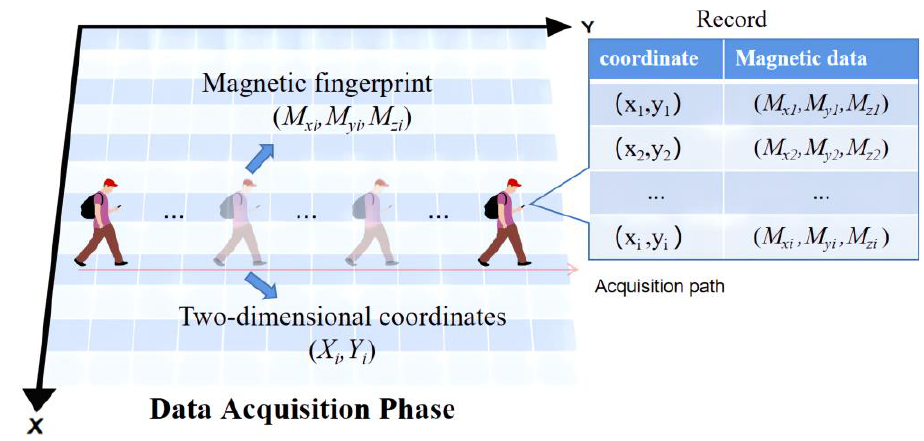
Figure 2. Data acquisition process.